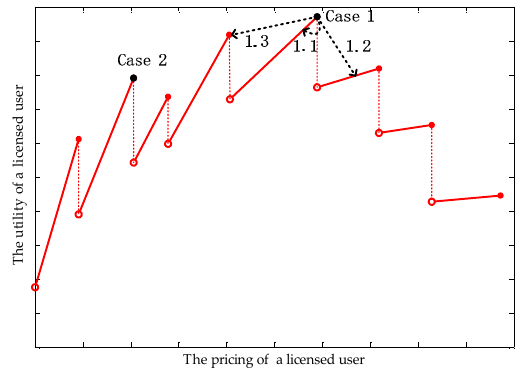
Figure 5. Cases of dishonest unlicensed user. Table 1. Analyses of all cases.